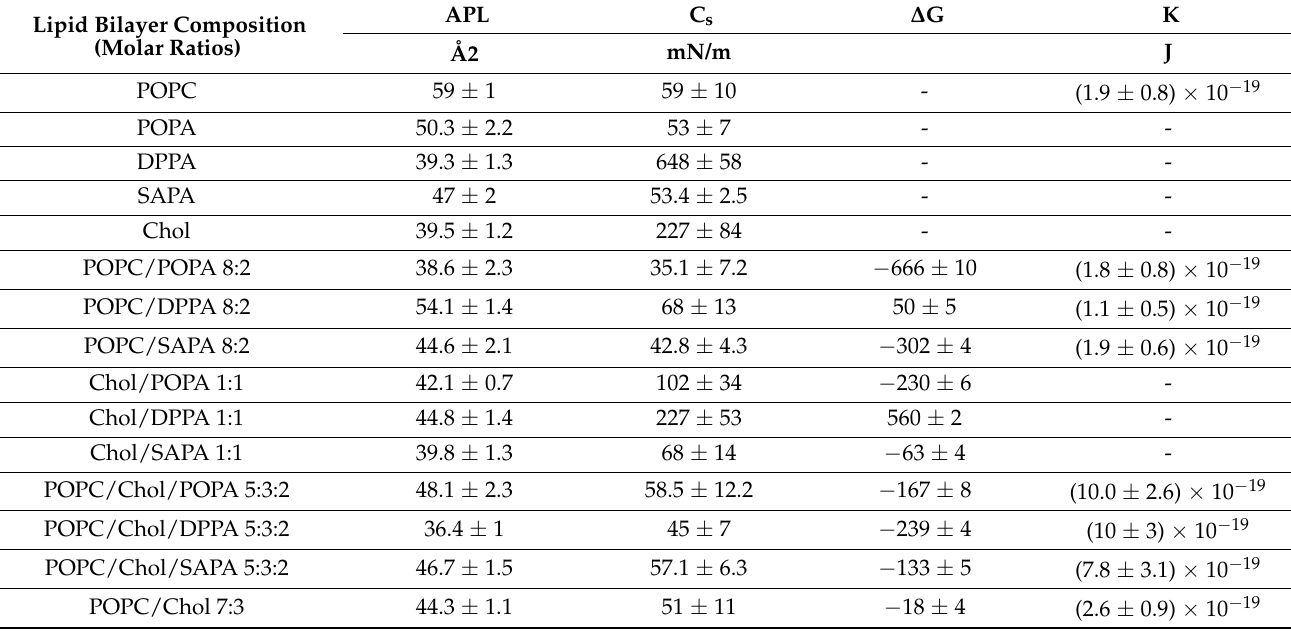
Table 2. Parameters describing membranes determined with experimental techniques–Langmuir monolayers (at pressure equal to 33 mN/m) and flicker noise